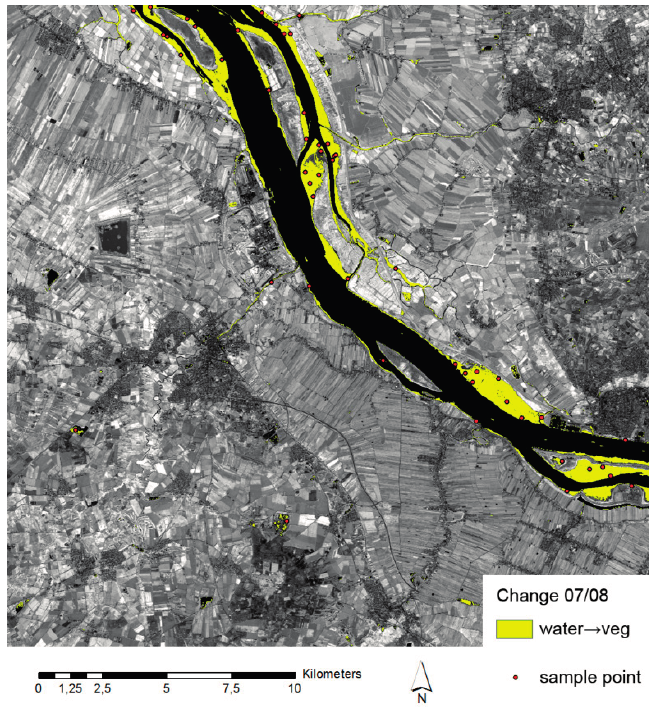
Figure 9. Sample points (red) in the area of change from water to non-vegetated area